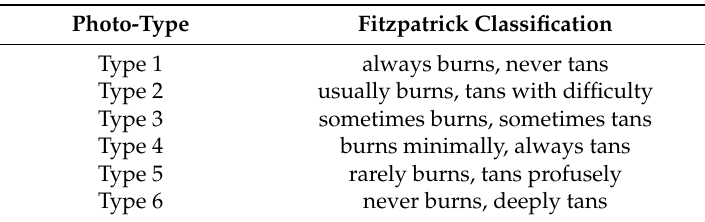
Table 3. Classification of skin types according to